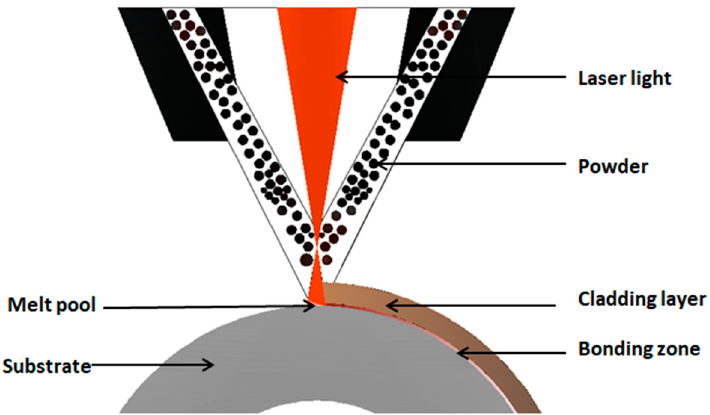
Figure 2. Schematic diagram of the laser cladding process.